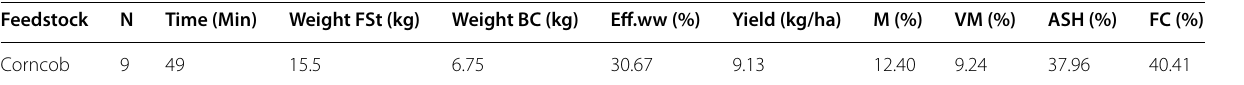
Table 3 Carbonization characteristics of the ELSA barrel and proximate analysis of the corncob biochar used for the previous